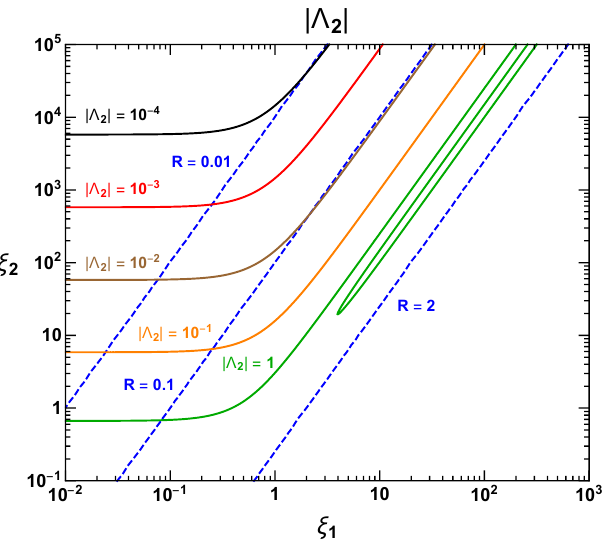
Figure 4 . Contours of j (cid:3) 2 j in units of M P in the plane of (cid:24) 2 and (cid:24) 1 in solid lines. We overlaid in blue dashed lines the contours of R = (cid:24) 1 =